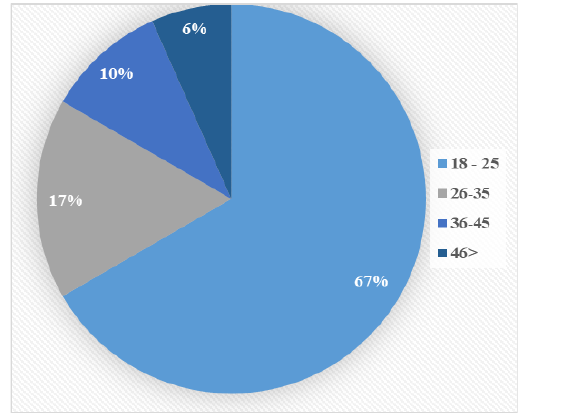
Figure 13. Feedback on mobile system components.